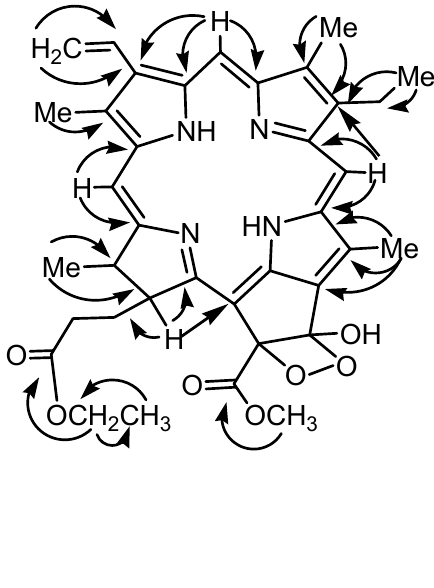
Figure 2. Key HMBC ( → ) correlations of ligulariaphytin A ( 1